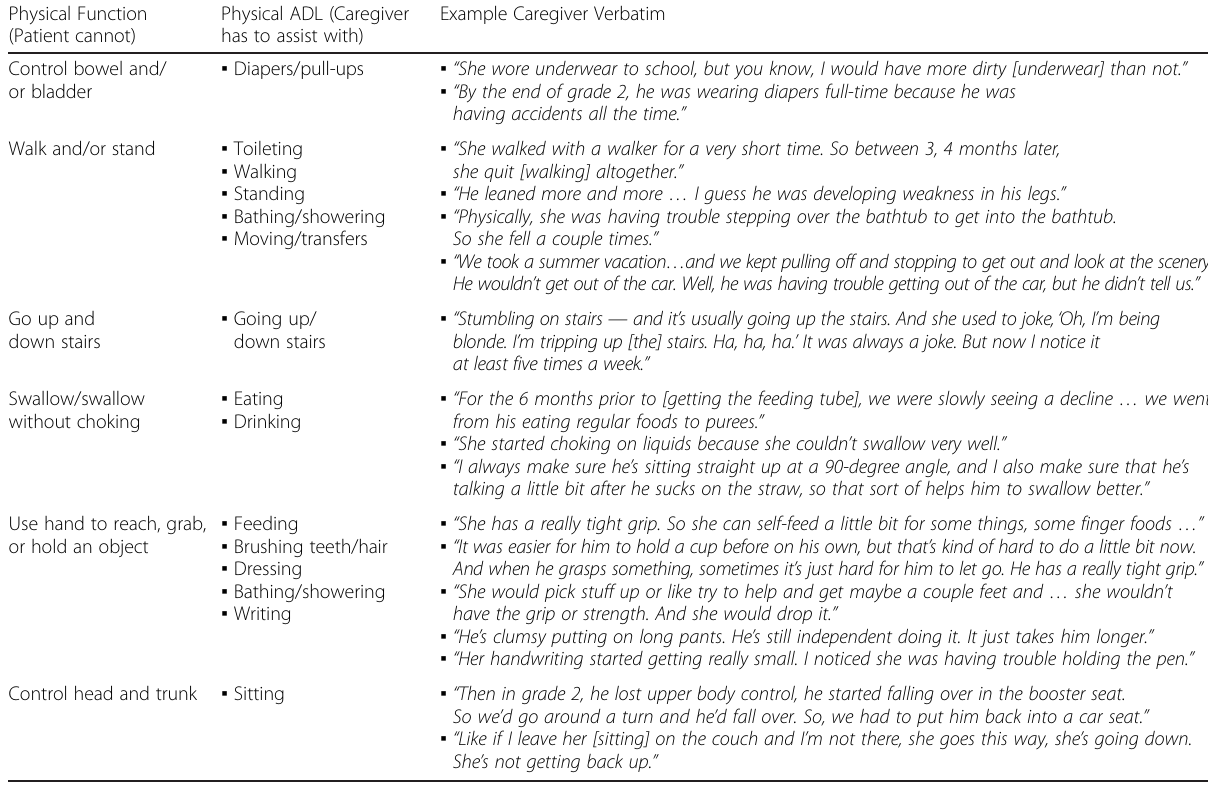
Table 2 Caregiver-Observed Impact of Physical Function on Physical ADLs Physical Function (Patient